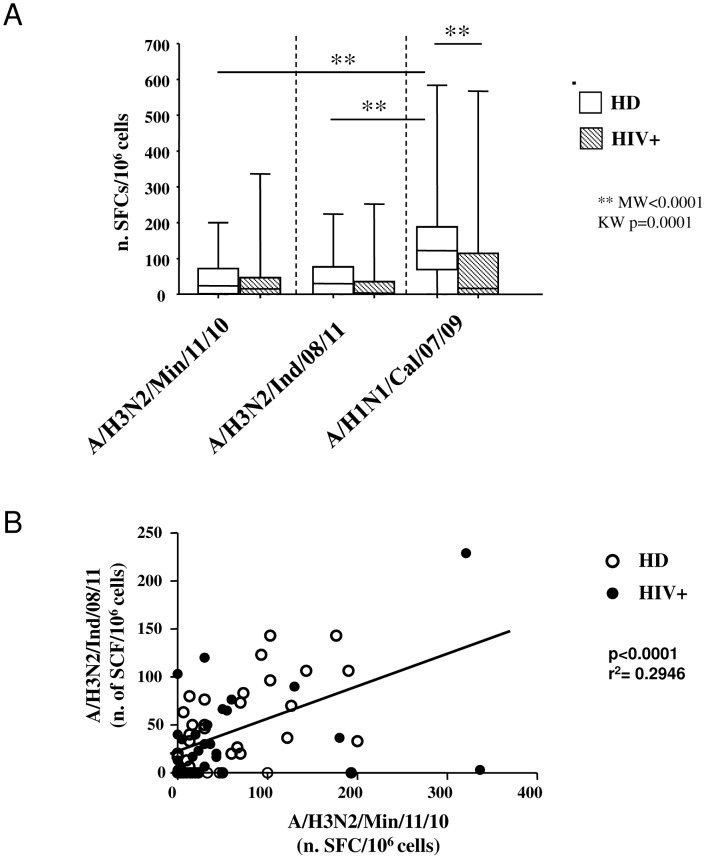
Cellular immune response to different influenza A virus strains.(A): The frequency of T-cell response specific for A/H3N2/Min/11/10, A/H3N2/Ind/08/11 and for A/H1N1/Cal/07/09 was evaluated by ELISpot assay in HD (n = 45, white bars) and HIV+ patients (n = 46 grey bars). Results are indicated as SCFs/106 peripheral mononuclear cells (PBMCs). Statistical analysis was performed using non parametric Mann-Whitney assay. ** p<0.0001. (B): The correlation between T-cell response against A/H3N2/Min/11/10 and A/H3N2/Ind/08/11 is shown, with Pearson's r2 and significance, as well as the calculated regression line. HD and HIV+ are reported as white and black circles, respectively.